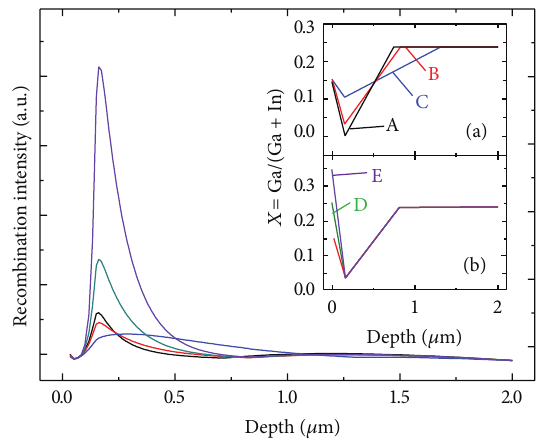
Figure 3: Recombination intensity of CIGS cells with different bandgap grading profiles taken under illumination with an intensity of 1 sun at 193